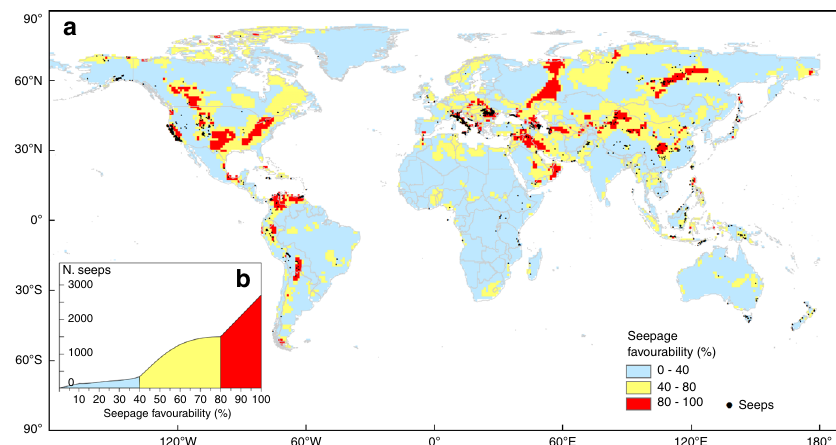
Fig. 4 Favourability map of gas seepage. a Map with the boundary of seepage probability classes selected according to the slope changes in the inset graph. The map suggests the potential areas where additional seeps (not identi fi ed in available inventories) and microseepage can occur. b Cumulative number of